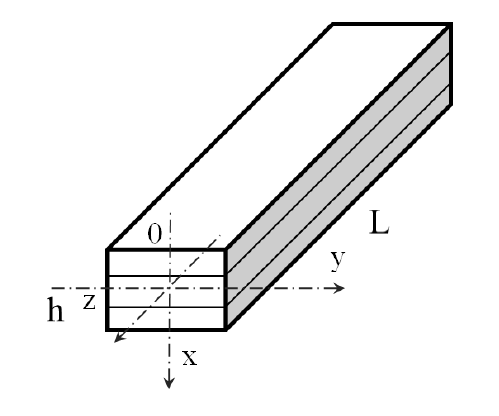
Figure 1. Laminated